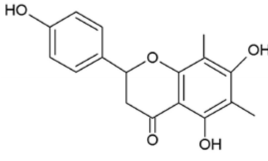
Figure 1. Chemical structure of farrerol.